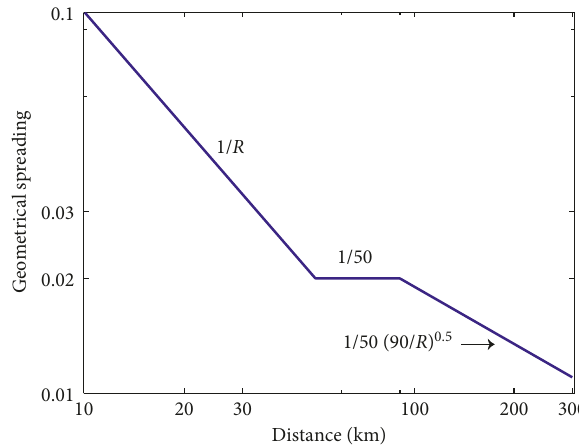
Figure 2: Geometrical spreading